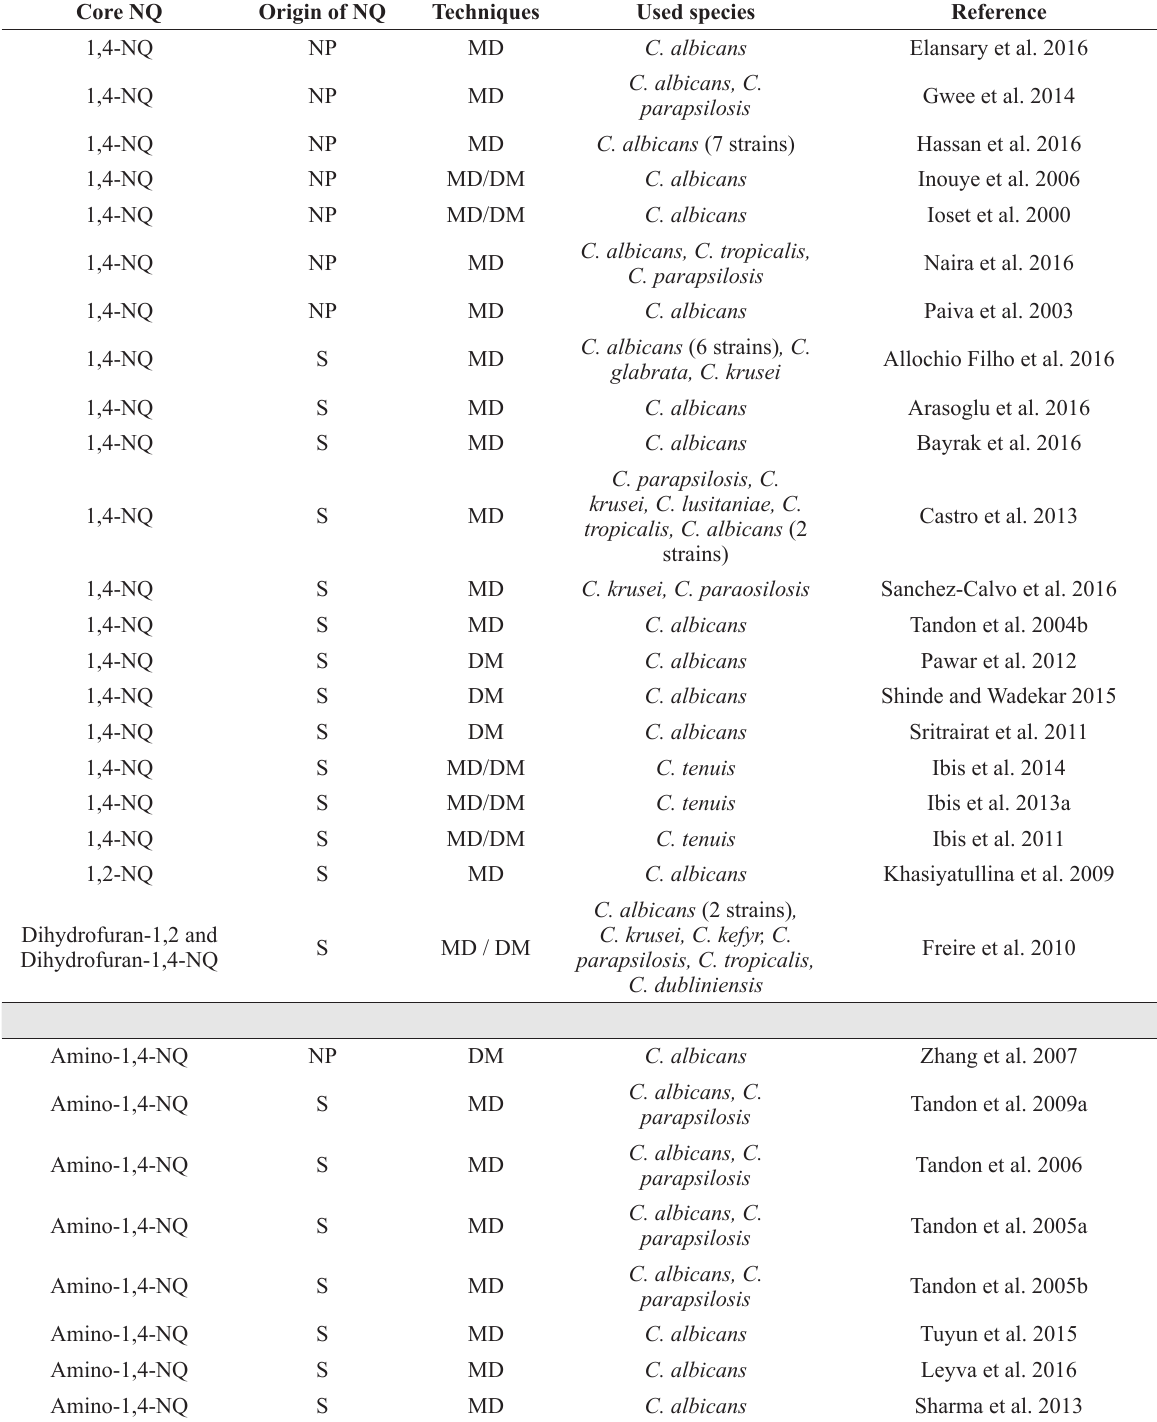
List of naphthoquinones, their origins, the techniques used for the measurement of their antifungal activity (disc diffusion method (DM) and/or the microdilution method (MD)) and the Candida spp used (Legend: NQ = Naphthoquinone; NP = Natural product; S =